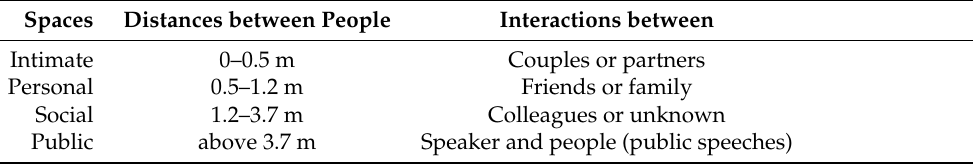
Table 1. Interpersonal distances of people.